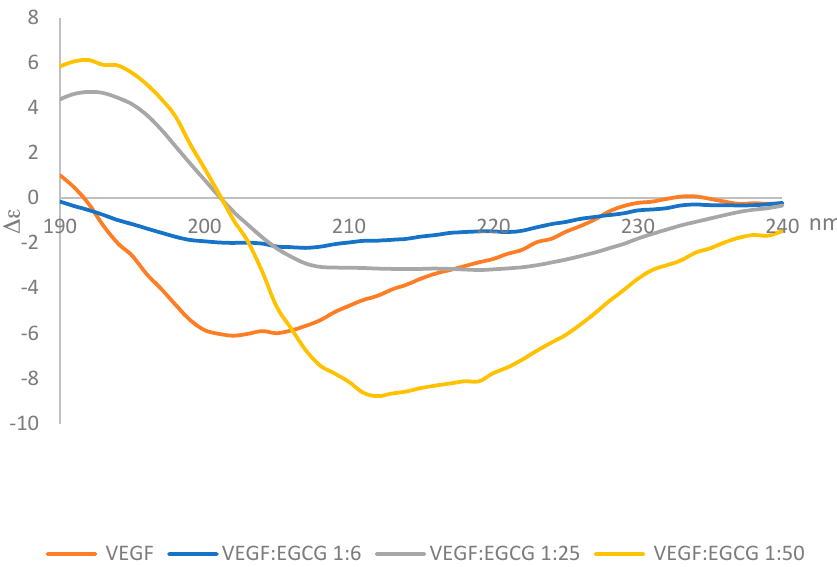
Figure 4. CD spectra of VEGF (blue) and at 3 min after mixing VEGF:EGCG at a 1:6; 1:25, and 1:50 molar ratio using 25 µL of VEGF 0.2 mg·mL − 1 and 25 µL of EGCG 0, 0.025; 0.1 and 0.2 mg·mL − 1 .